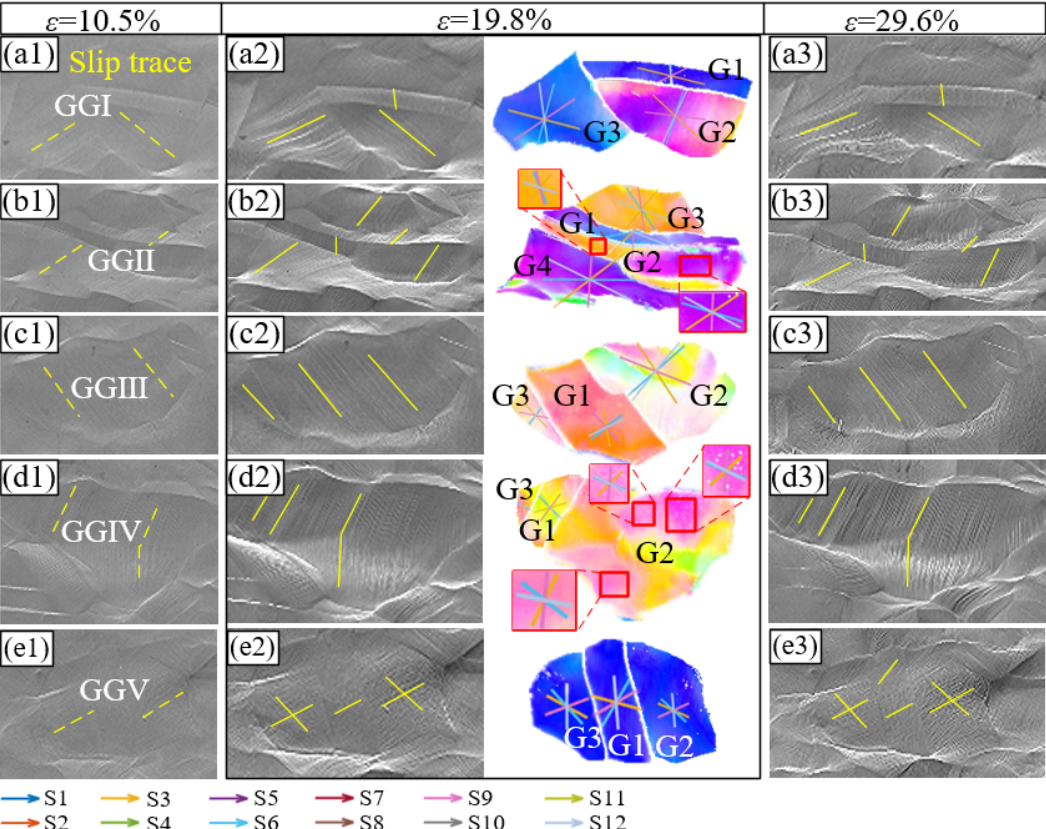
Figure 5. SEM and OIM of grain groups ( a1 – a3 ) GG Ⅰ , ( b1 – b3 ) GG Ⅱ , ( c1 – c3 ) GG Ⅲ , ( d1 – d3 ) GG Ⅳ , and ( e1 – e3 ) GG Ⅴ at strain values of 10.5%, 19.8%, and 29.6%, respectively. The yellow lines in SEM diagrams are slip traces on the surface of the sample. The colored lines in OIM represent the different slip systems in grains. The G1, G2, G3, G4 are the numbers of corresponding grains. Using the MTEX toolbox, we calculated the corresponding Schmid factors of 12 slip systems under different strain conditions in the observed area. With an increase in